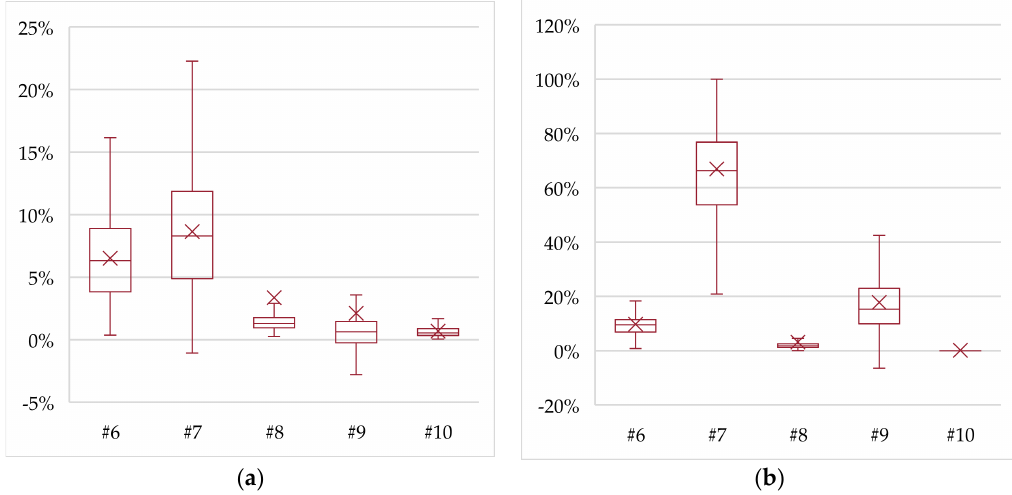
Figure 8. Resulted savings of ( a ) primary energy consumption; ( b ) local emissions.